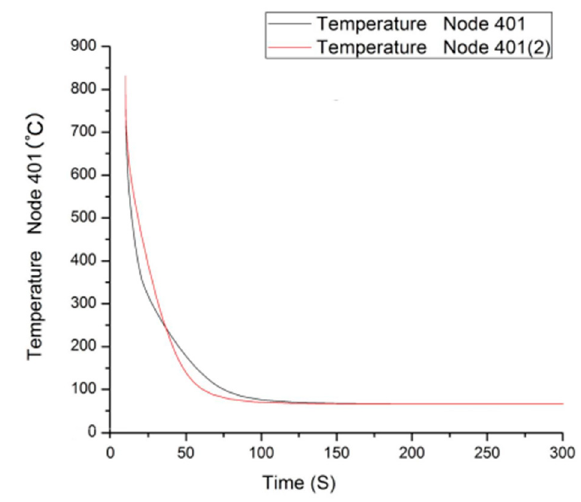
Figure 9. The comparison of the curve on node 401.